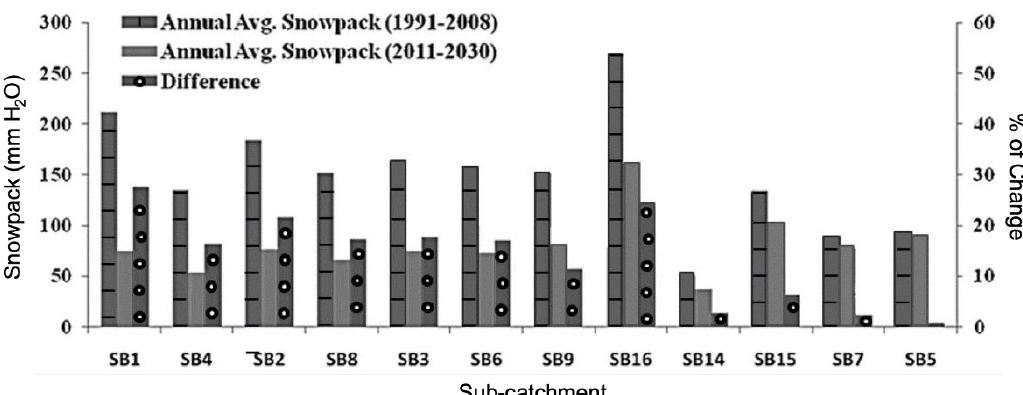
Figure 8. Percentage of change in snowpack amount (average annual) over different sub-catchments of Satluj river.